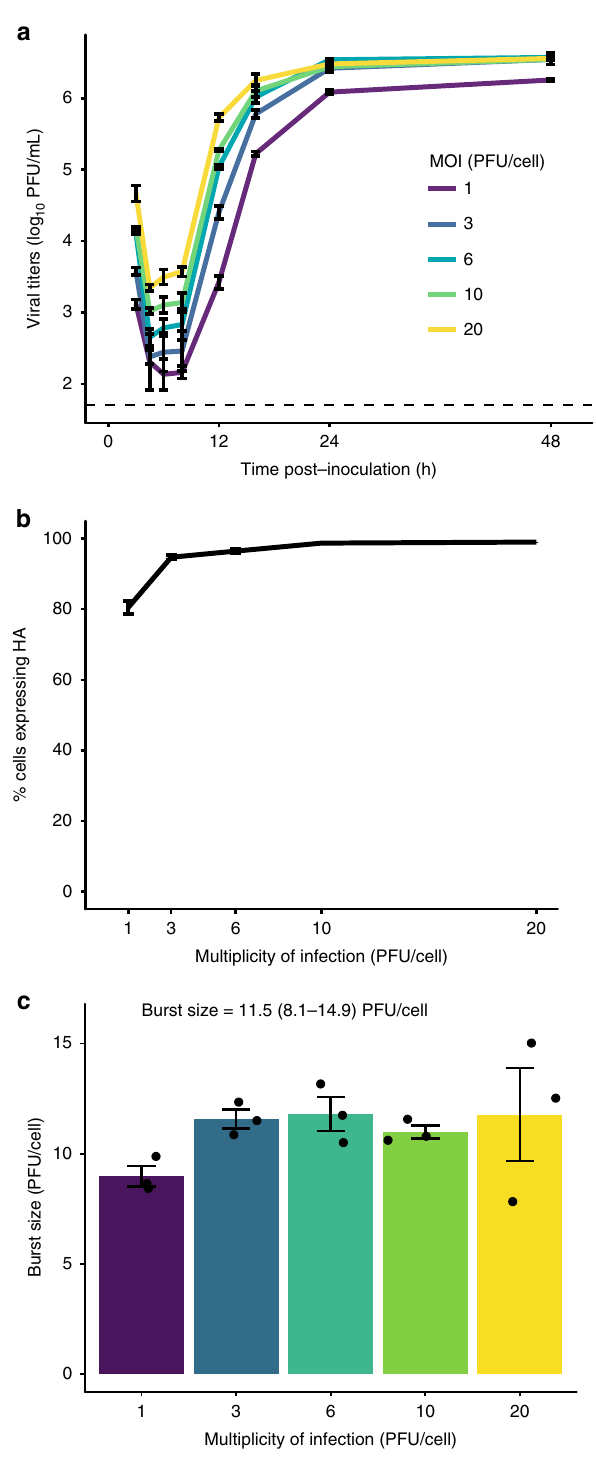
fl ow cytometry targeting these epitope tags to measure the potential for complementation — that is, the bene fi t provided by the addition of Pan/99-Helper virus. We hypothesized that, under single-cycle conditions, the potential for complementation would decrease with increasing WT virus MOI, since complementation between coinfecting WT viruses would occur frequently at high MOIs. In addition, under multi-cycle conditions initiated from low MOI, we predicted that the potential for complementation would be greatest at the beginning of infection, due to the random